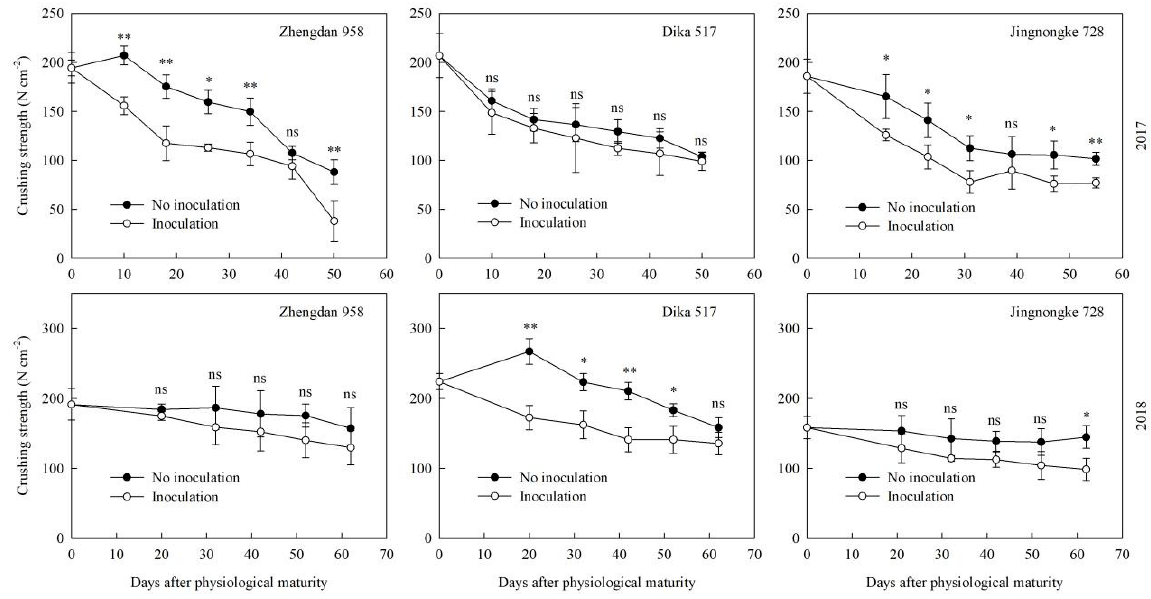
Figure 9. Internode crushing strength after physiological maturity of different maize cultivars with an inoculation of Pythium aristosporum . * and ** represent significant differences between inoculation and no inoculation at 0.05 and 0.01 levels, respectively, “ns” represent no significant difference.